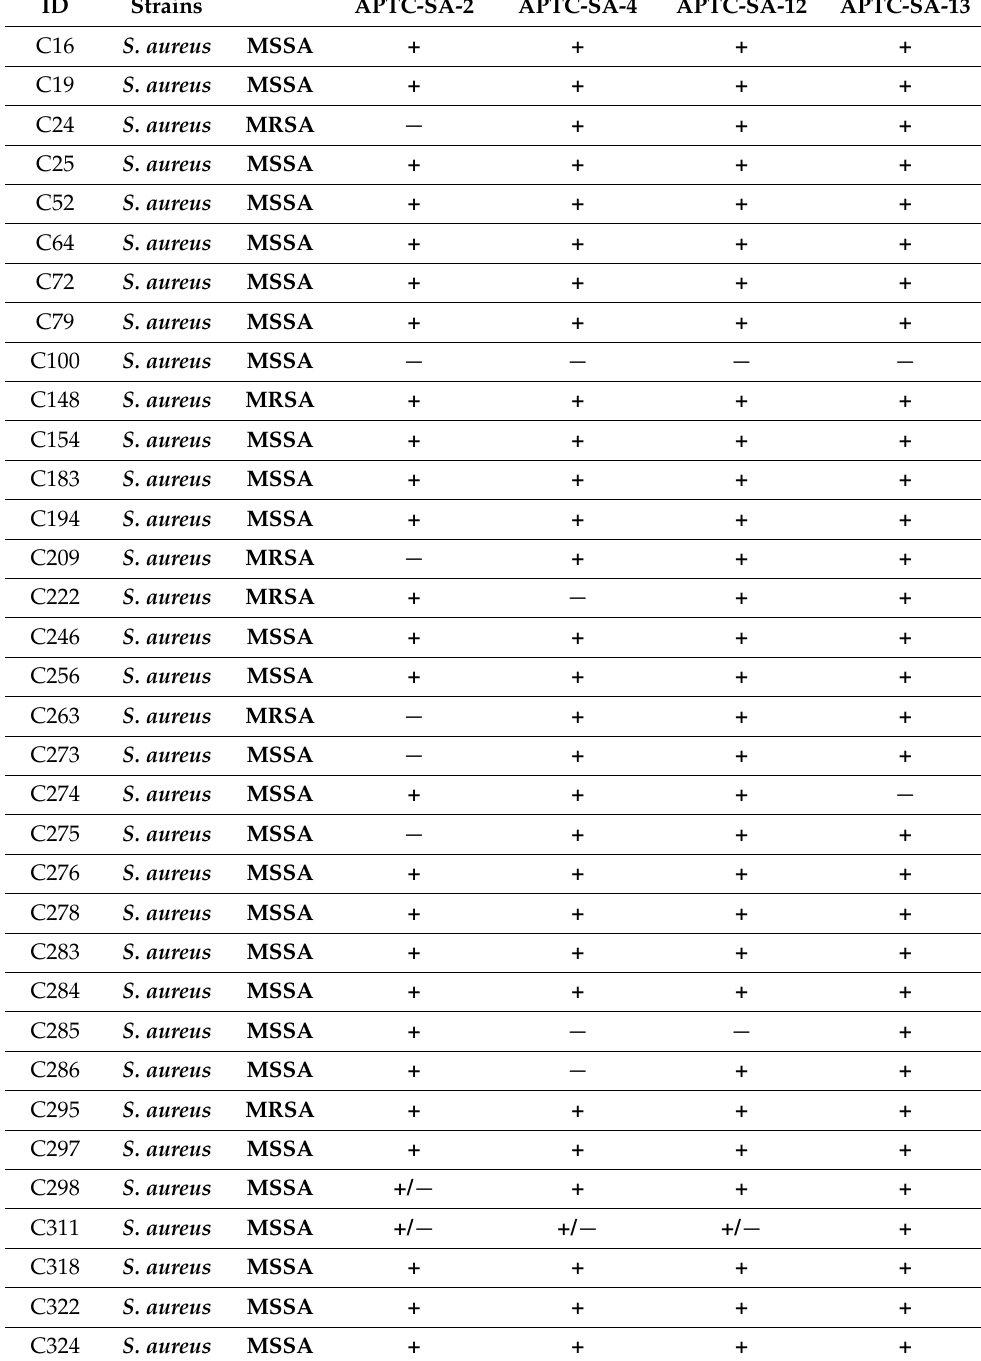
be resistant to at least one of the phages tested (35%). From those, only one strain (C100) was found to be resistant to all four phages and another one strain (C331) was found to be sensitive to only one of the phages tested. The remaining 16 strains were sensitive or semi-sensitive to at least 2/4 phages tested, indicating a high complementarity of 49/51 strains (96%). The combination of the four phages in a cocktail APTC-C-SA01 could lyse 50/51 (>98%) S. aureus strains when used at MOI = 0.1. Phage sensitivity for the four phages against all tested S. aureus strains is shown in Table 1. Table 1. S. aureus phages’ host range. ID Strains APTC-SA-2